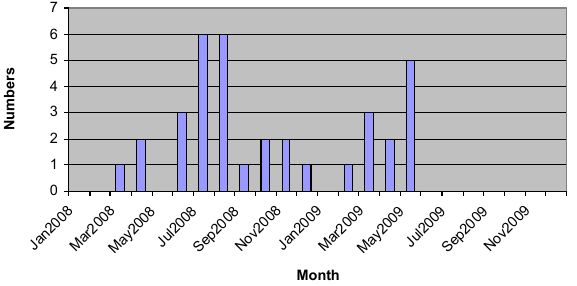
Figure 1. Maximum number of Red Pierrot Butterfly Talicada nyseus observed during any observation in a month from January 2008